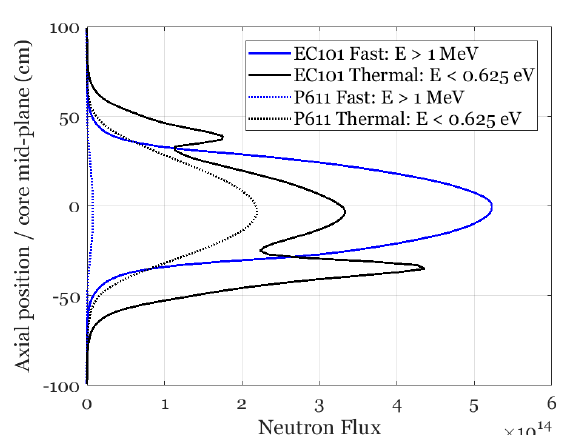
Fig. 5. Axial profile of thermal and fast neutron flux at the core (for MICA) and reflector (for OCCITANE) irradiation positions.